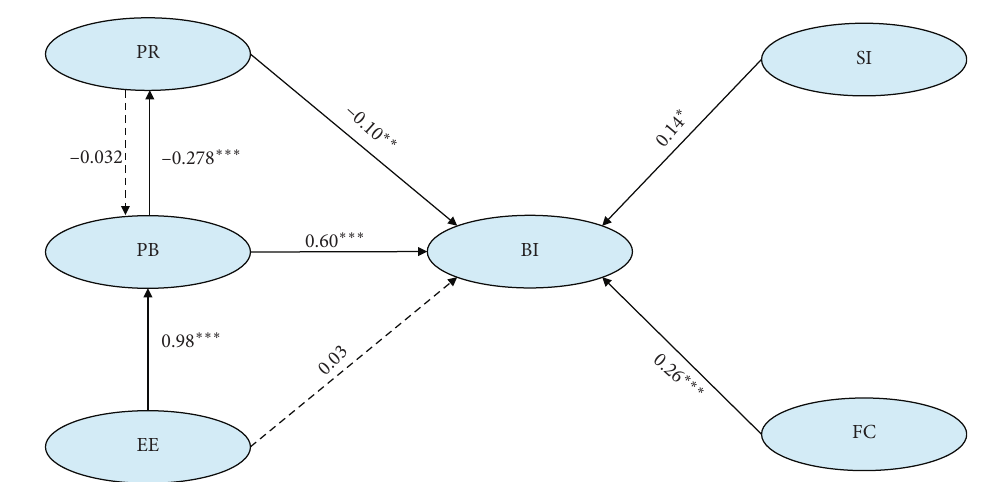
Figure 3: Path relationships between latent variables.